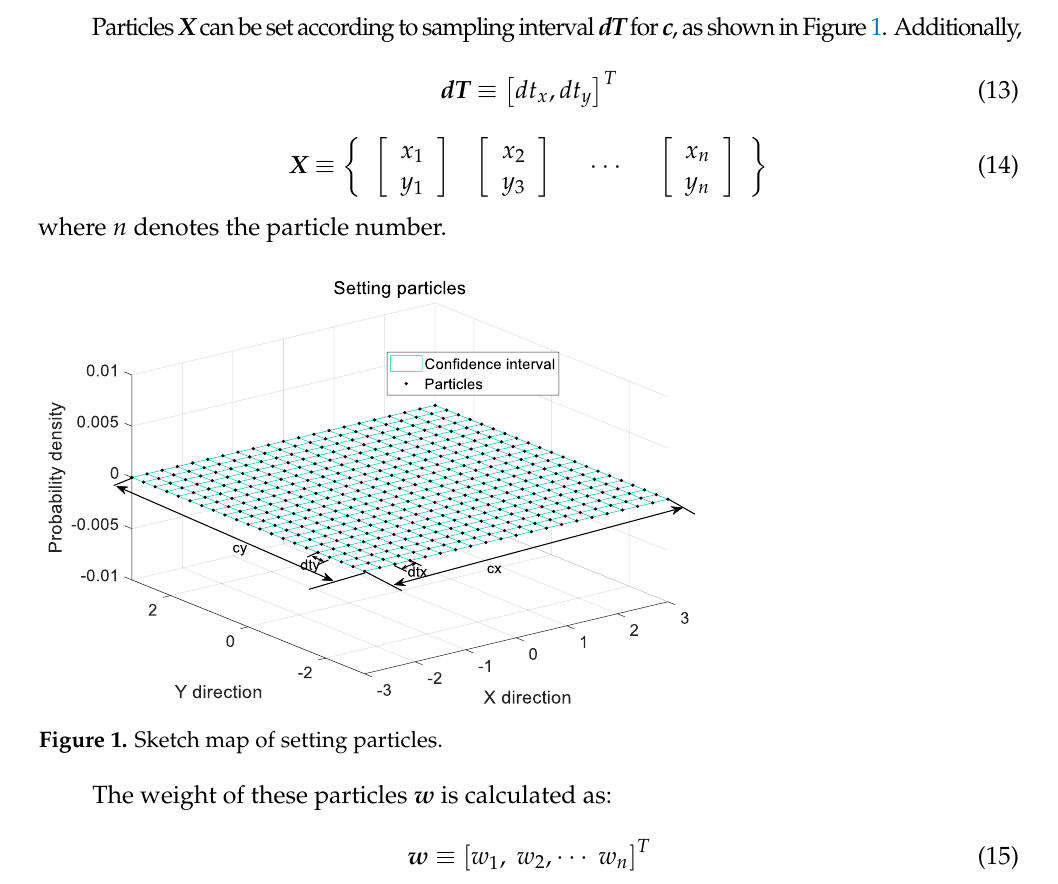
d T in the confi-